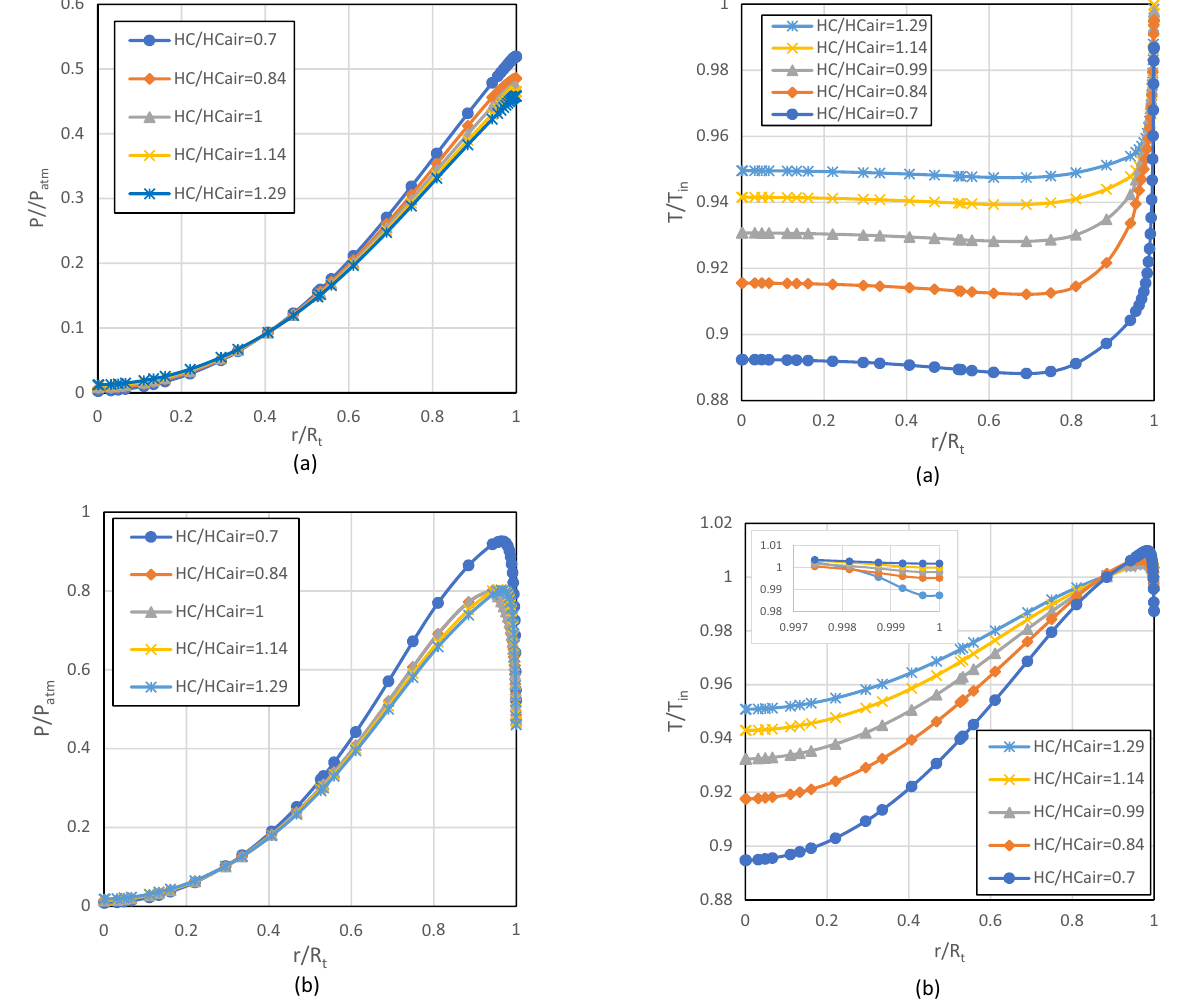
Fig. 16 Dimensionless temperature profiles versus dimension- less radial direction plotted at z∕L = 0.63 for various heat capacity ratios. a Static and b total temperatures with 400 kPa at the inlet, 0 kPa at the cold outlet and 30 kPa at the hot